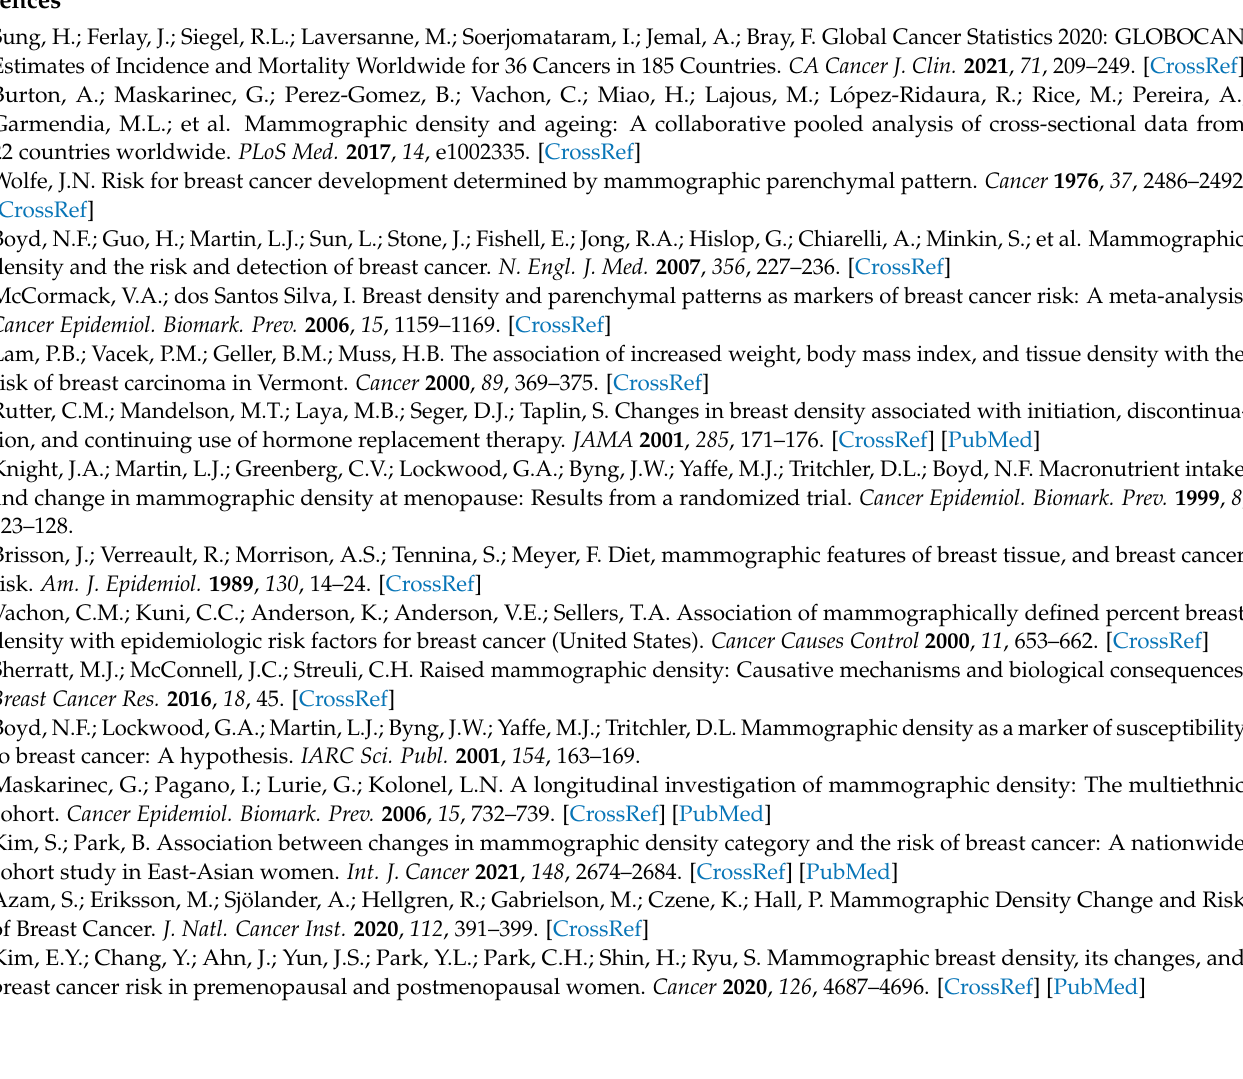
10.3390/cancers13194805/s1: Figure S1: Funnel plot for pooled analysis of breast cancer risk in relation to increased breast density over time (cohort studies); Figure S2: Funnel plot for pooled analysis of breast cancer risk in relation to decreased breast density over time (cohort studies); Figure S3: Funnel plot for pooled analysis of breast cancer risk in relation to increased breast density over time (studies presenting odds ratios); Figure S4: Funnel plot for pooled analysis of breast cancer risk in relation to decreased breast density over time (studies presenting odds